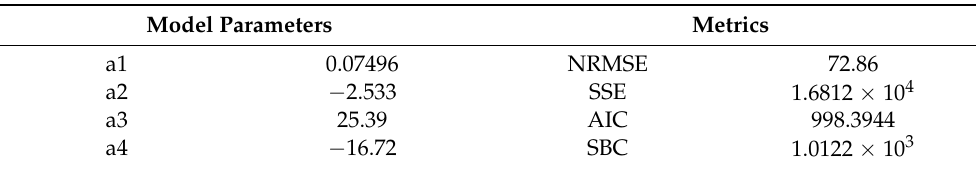
Table 16. Overview of the parameters of the created custom model and performance metrics of the DMSP-5 muscle validation results.